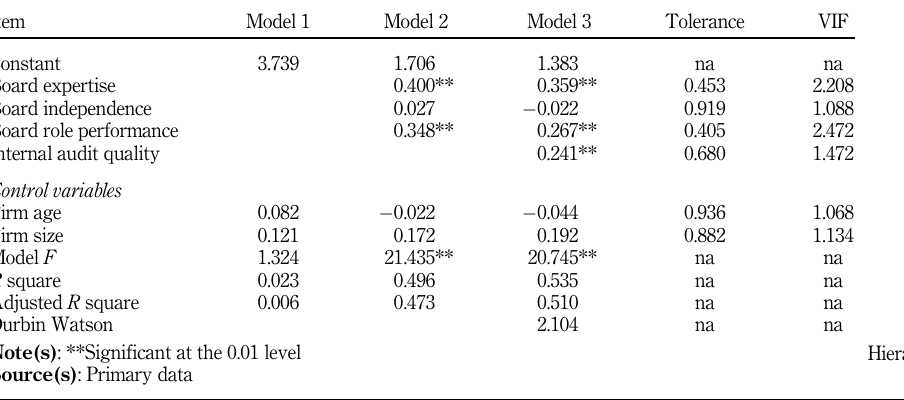
Table 5. Hierarchical regression